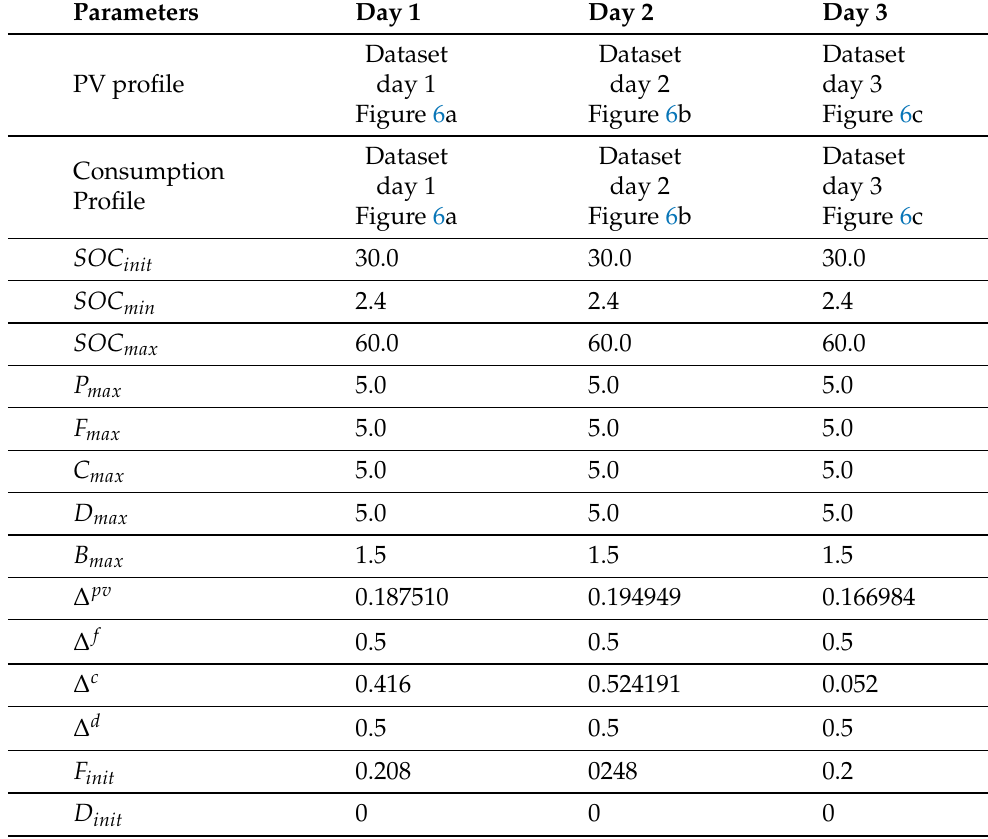
Table 4. Problem instances for EM